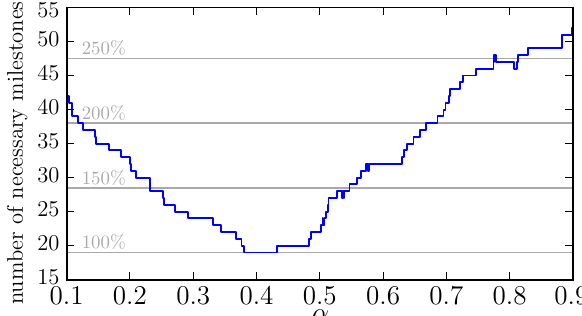
Figure 4. A mountain bike trajectory (bold) close to Bonn. Road segments of favored types are depicted as blue lines, those of unfavored types as red lines.